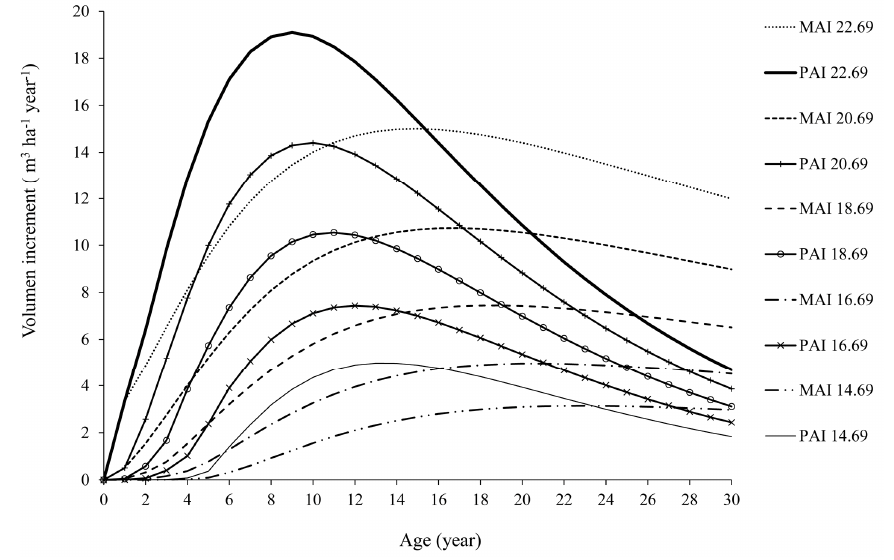
Figure 5. Mean annual increment ( MAI ) per hectare for different site indices considering a density of 160 teak trees ha − 1 planted as living fences in SPS. The dashed line represents the periodic annual increment ( PAI ) per hectare. The solid line indicates the MAI . The local maximum MAI can be considered the optimal biological rotation age for each SI class.